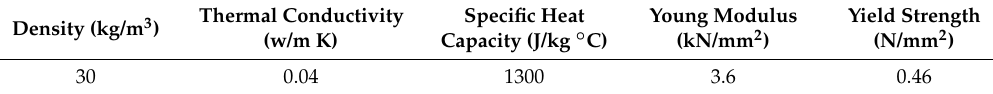
Table 3. The mechanical and thermal properties of EPS.